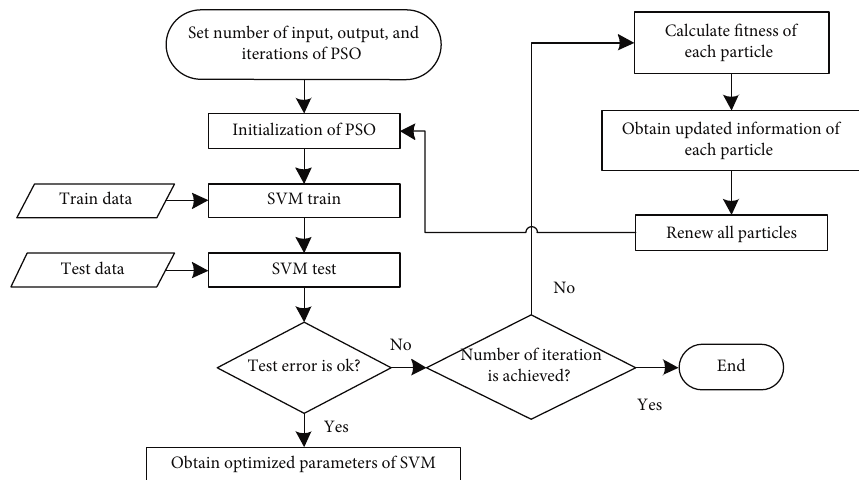
Figure 3: The flowchart of SVM-PSO.